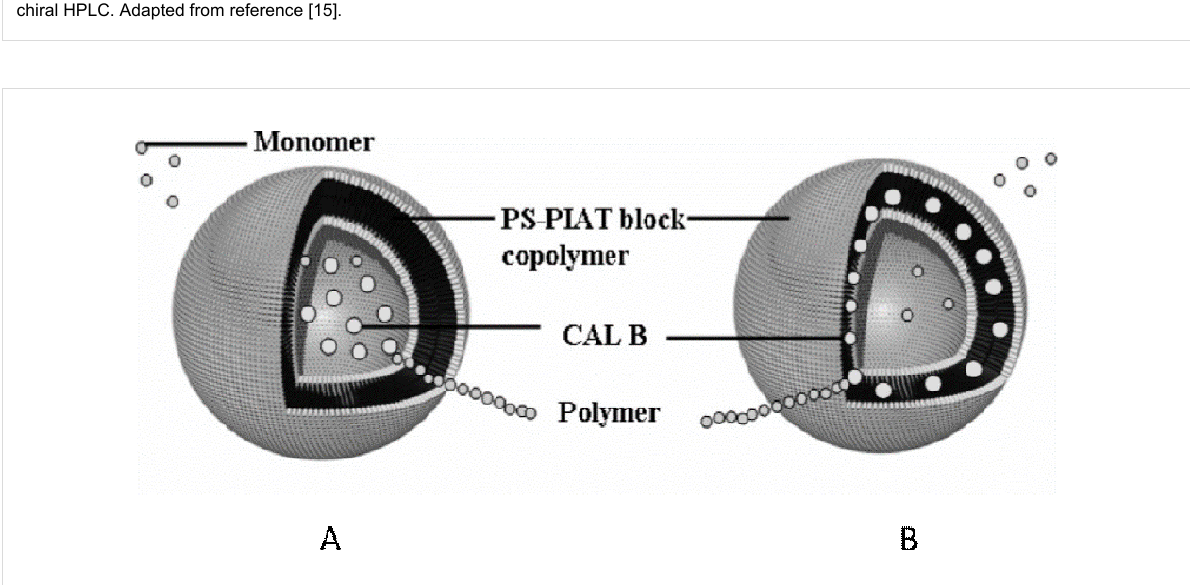
Figure 5: Schematic representation of enzymatic polymerization in polymersomes. (A) CALB in the aqueous compartment (B) CALB embedded in the bilayer. Reprinted with permission from [21]. Copyright 2007 American Chemical Society.